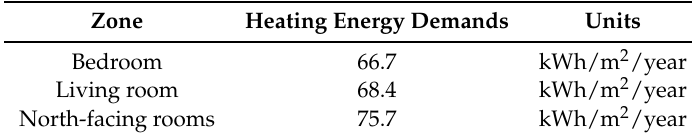
Table 6. One-year heating energy demands inside the bedroom, living room and north-facing rooms for the reference